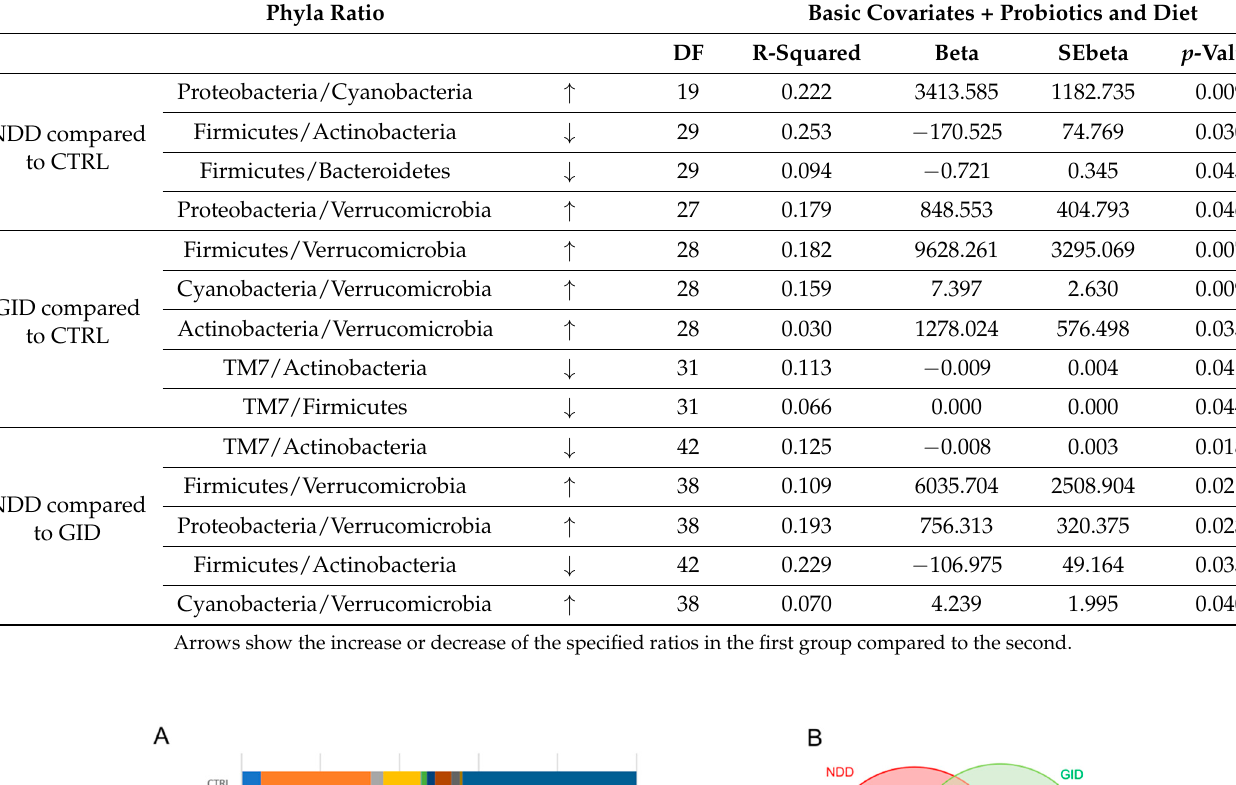
Table 2. Significant phyla ratio changes among neurodevelopmental disorder (NDD) and gastrointestinal disorder (GID) groups.